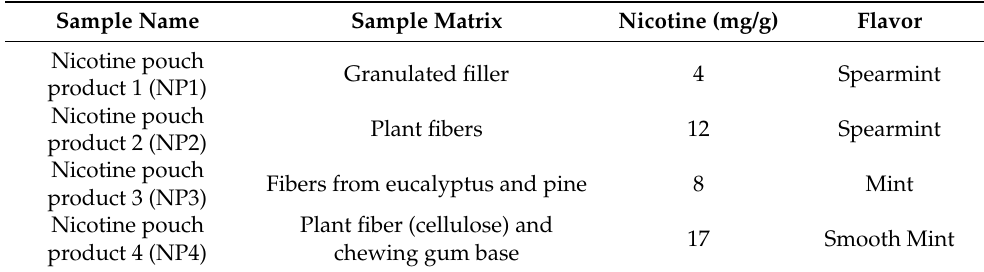
Table 2. Description of nicotine pouch products.